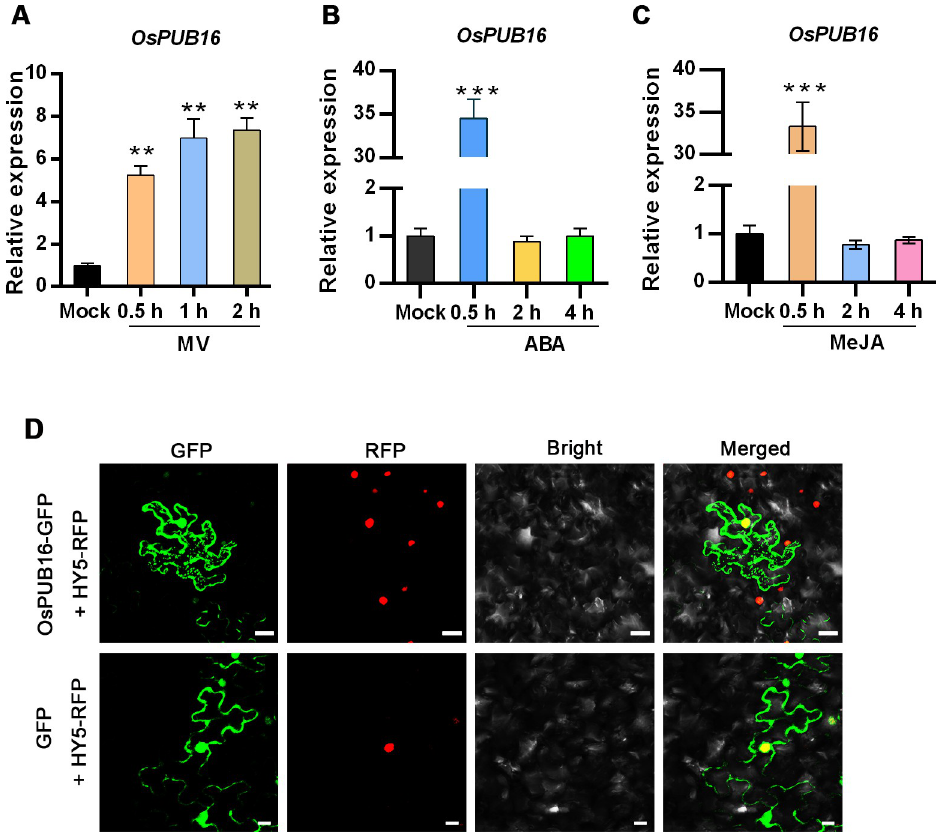
Fig 1. OsPUB16 expression pattern and the subcellular localization of its protein. (A-C) OsPUB16 expression in response to MV (methyl viologen) (A), ABA (B) and MeJA (C) at indicated time. Relative transcription levels of OsPUB16 in the leaves of 2-week-old wild-type (Nipponbare) plants treated with 10 μ M MV, 100 μ M ABA or 100 μ M MeJA for different time. Error bars indicate SD ( n = 3 biological replicates). OsActin1 was used as the internal control. The significant difference between mock and treatment was determined by Student’s t test. �� p < 0.01, ��� p < 0.001. (D) Subcellular localization of OsPUB16 in the epidermal cells of Nicotiana benthamiana leaves. GFP fluorescence signals were visualized using the confocal microscope (Leica SP8). HY5-RFP, the nuclear-localized marker. Scale bars, 40 μ